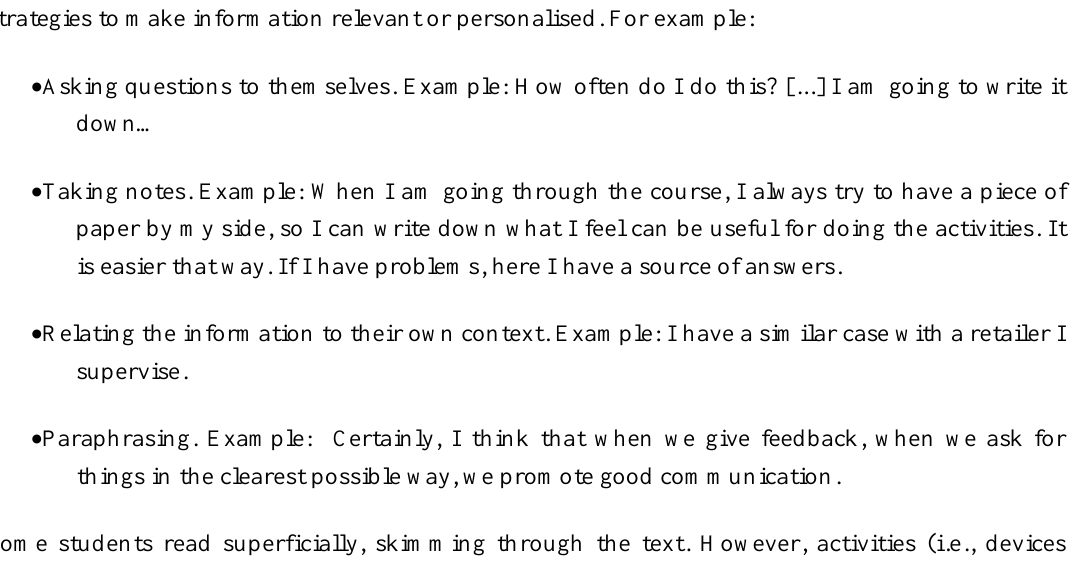
Version 1: Learner-Content